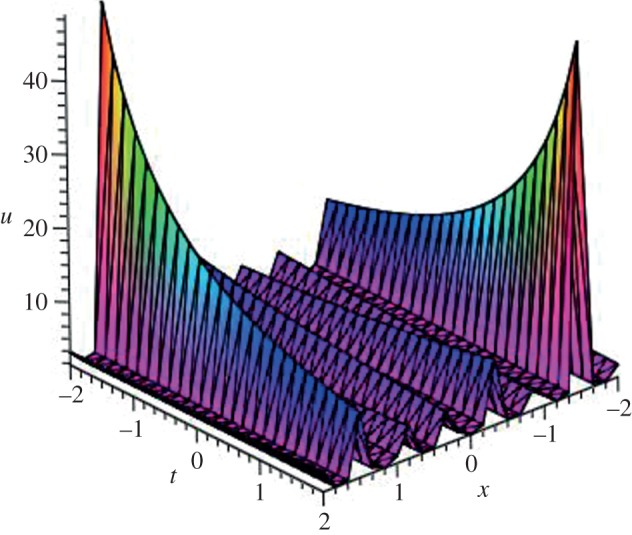
Periodic solution u39(ξ) of mBBM equation for a=3, b=7 and k=7.